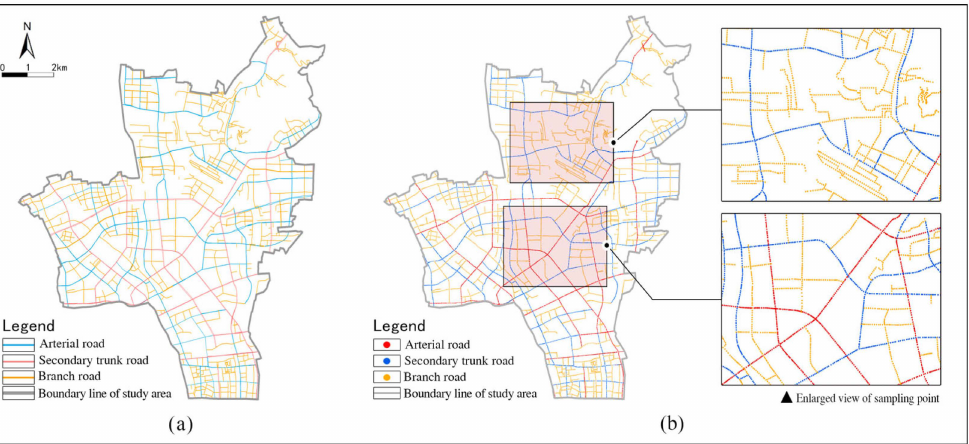
Figure 3. Street network data and street view sampling points: ( a ) Road network data of streets; ( b ) Street view sampling points in the study area.